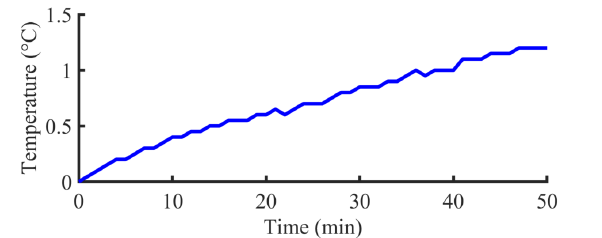
Figure 11. Temperature increase verification